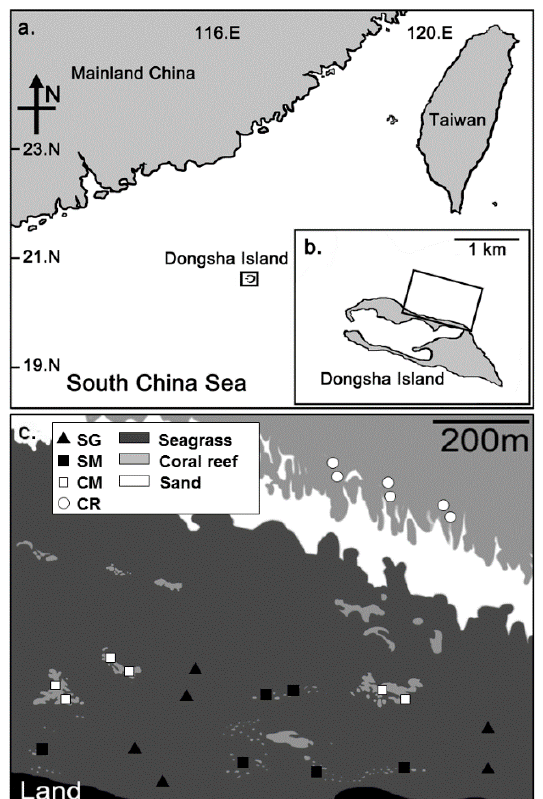
Figure 1. The location of ( a ) Dongsha Island in the South China Sea, ( b ) the study area (square inset) on the northern coast of Dongsha Island, and ( c ) the locations of the 24 study sites, which spanned seven habitat structure categories (defined in the legend).